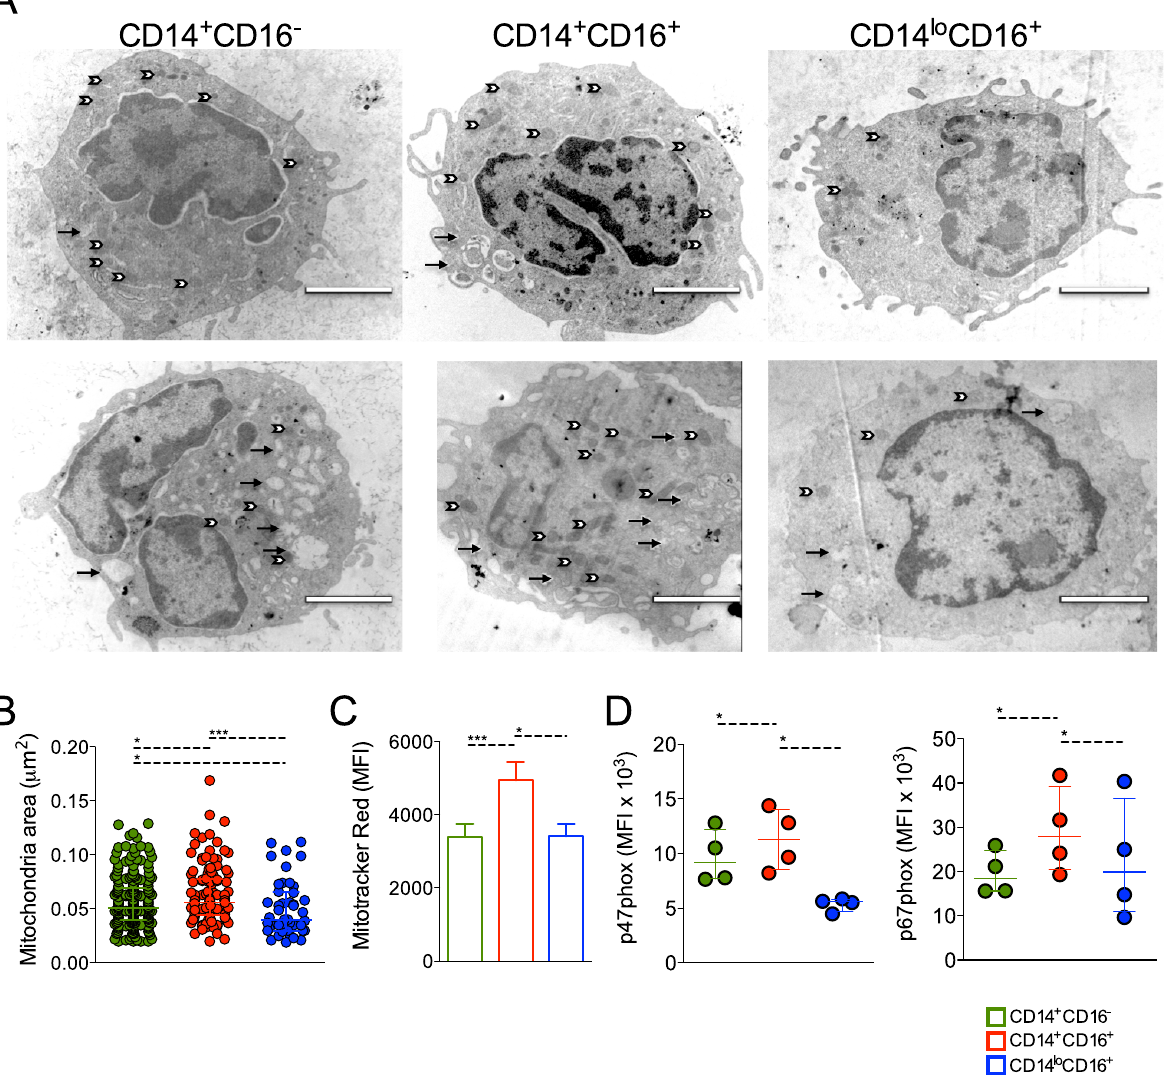
Figure 5. Circulating monocyte subpopulations display distinct morphology, mitochondrial and NADPH subunit content. FACS- sorted CD14 + CD16 2 , CD14 + CD16 + and CD14 lo CD16 + monocytes from healthy donors and P. vivax -infected patients were fixed and prepared for electron microscopy. Monocyte subsets from a single healthy donor (A, upper panel) and a single patient (A, lower panel) shown are representative of the analysis of at least six cells of each monocyte subpopulation per patient and of the analysis of 5 controls and 6 patients. Mitochondria (white arrows) and vesicles (black arrows). Scale bar, 2 m m. (B) Mitochondria area from CD14 + CD16 2 (green circles), CD14 + CD16 + (red circles) and CD14 lo CD16 + (blue circles) monocytes was assessed using ImageJ. Circles indicate individual mitochondria. (C) Mitochondria content in CD14 + CD16 2 (green bars), CD14 + CD16 + (red bars) and CD14 lo CD16 + (blue bars) monocytes from P. vivax -infected patients was measured based on Mitotracker reactivity (n=11). (D) Mean fluorescence intensity (MFI) of p47phox and p67phox within CD14 + CD16 2 , CD14 + CD16 + , CD14 lo CD16 + monocytes from P. vivax -infected patients was measured by flow cytometry 3 hours after culture in medium alone or P. vivax -infected reticulocytes (n=4). Results are representative of 2 independent experiments. Symbols represent individual subject. * p , 0.05, *** p , 0.01.